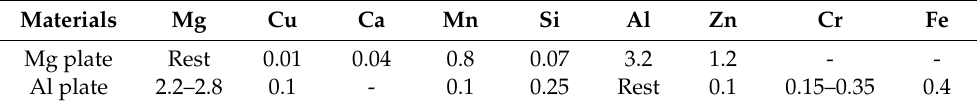
Table 1. Chemical compositions (in wt.%) of AZ31B Mg plate and 5052 Al plate. Materials